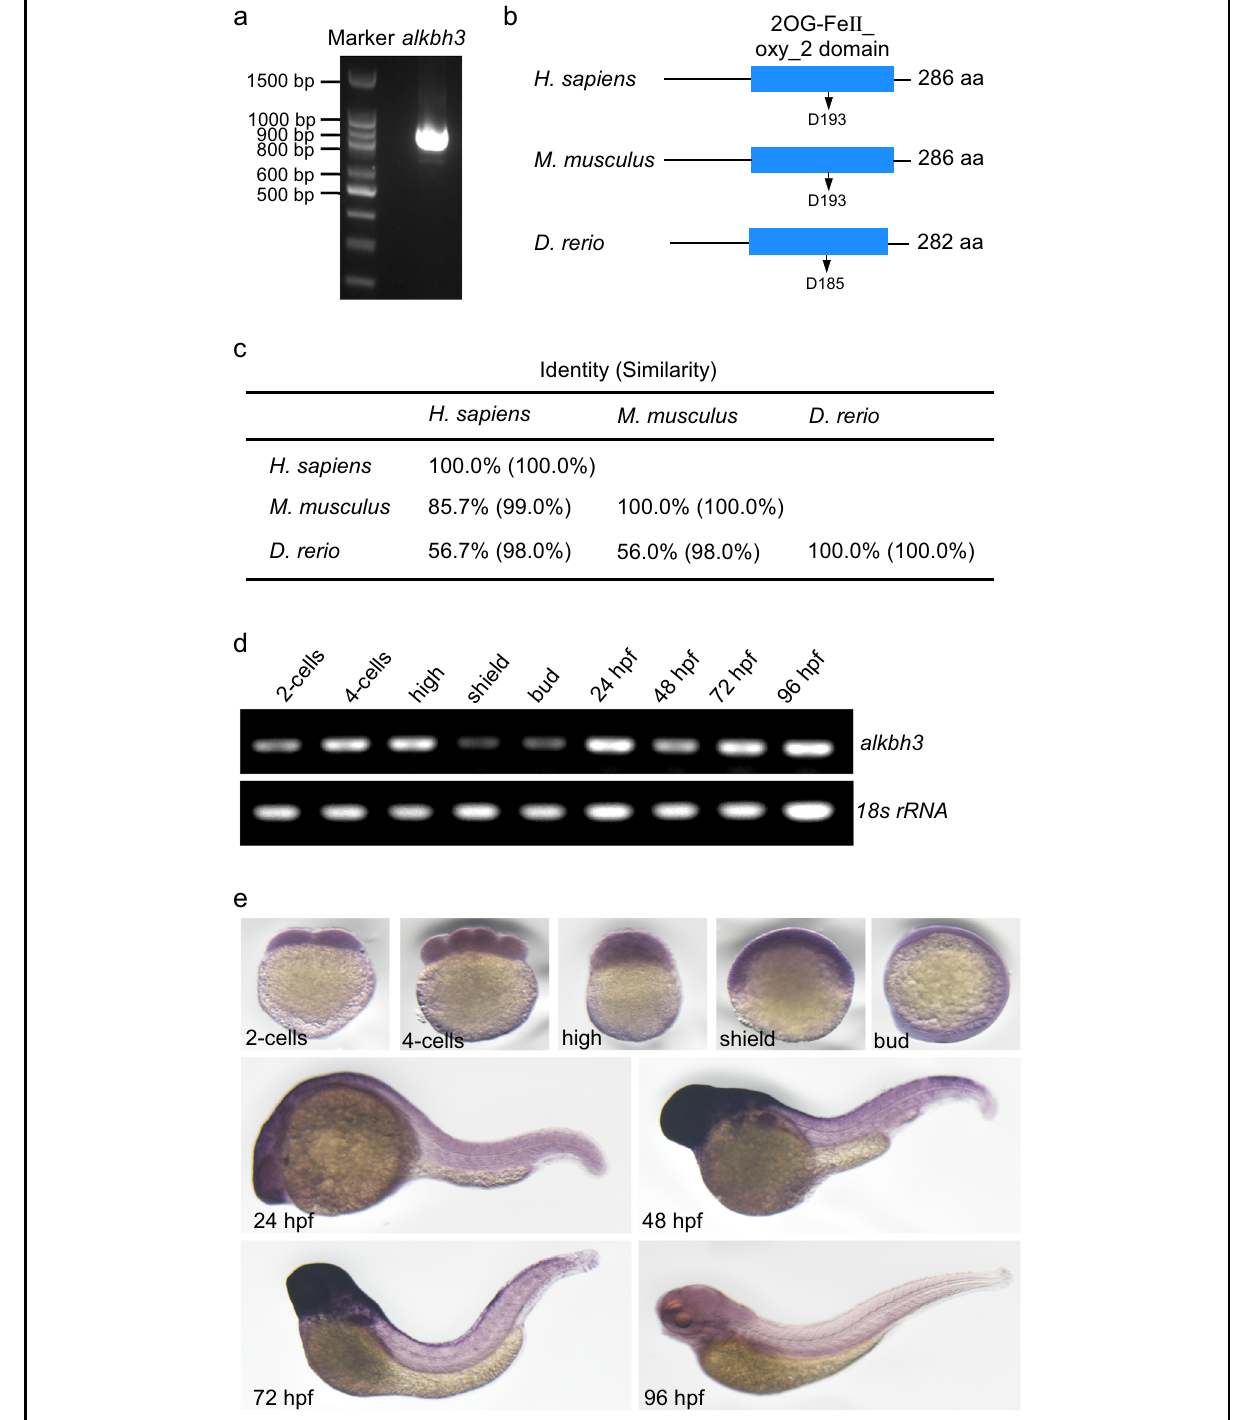
Fig. 5 Molecular characterization of zebra fi sh alkbh3 gene. a Cloning of zebra fi sh alkbh3 by reverse transcription PCR. b , c Schematic comparison of ALKBH3 amino acid sequences from the indicated species. The conserved 2OG-Fe (II) oxygenase superfamily domains are shown in blue fi lled bars. The conserved amino acid residues D193 and D185 are indicated, respectively. d Reverse transcription PCR analysis of alkbh3 mRNA at the different embryonic stages in zebra fi sh. 18s rRNA was served as a loading control. e Whole-mount in situ hybridization of zebra fi sh alkbh3 mRNA at the indicated developmental stages in lateral